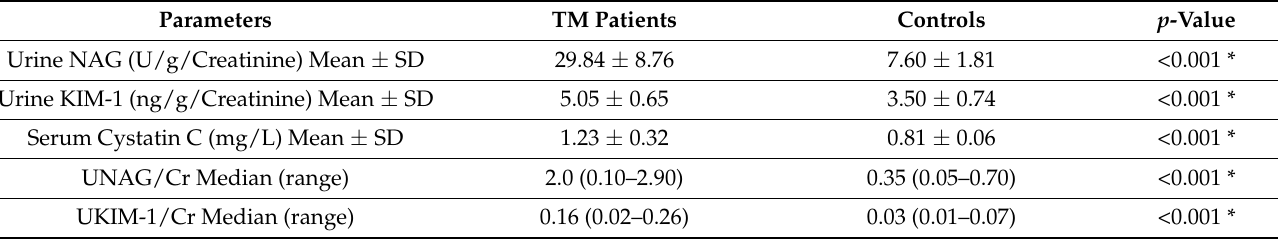
Table 3. Serum cystatin-C, urinary NAG, urinary KIM-1 among studied groups.